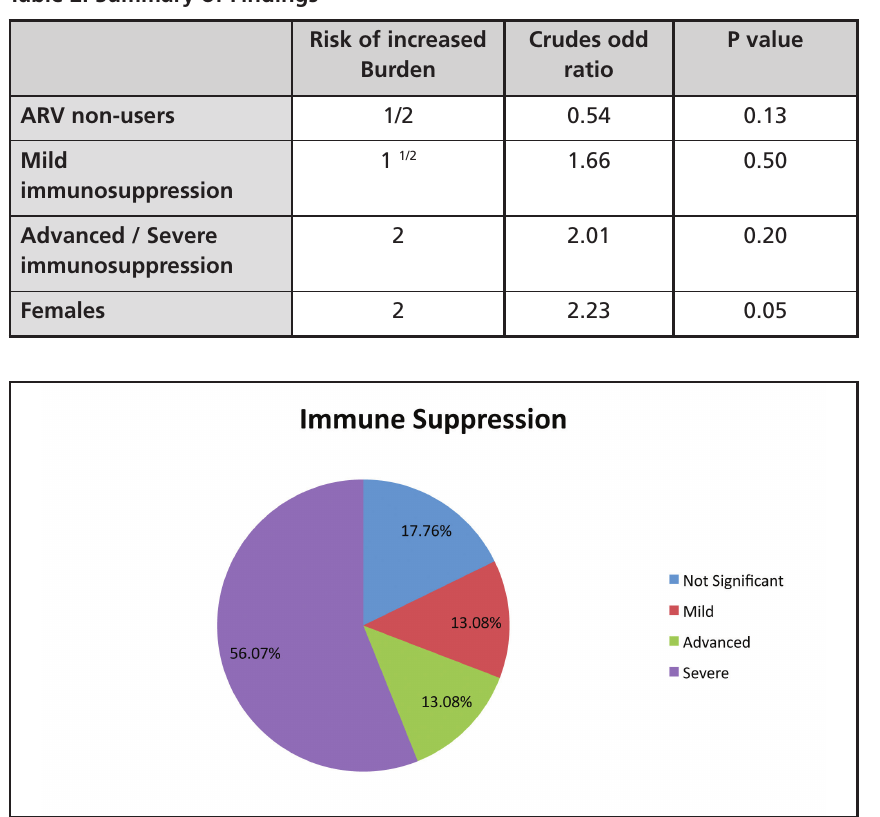
Figure 5: Level of